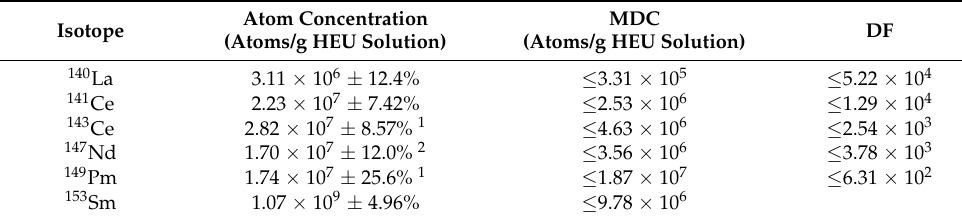
Table 4. The results of the gamma spectroscopic analysis of the separated Sm fraction; fraction 7 from each sample was counted for 1.42 h. Samples were run in quadruplicate and 1 σ uncertainty.